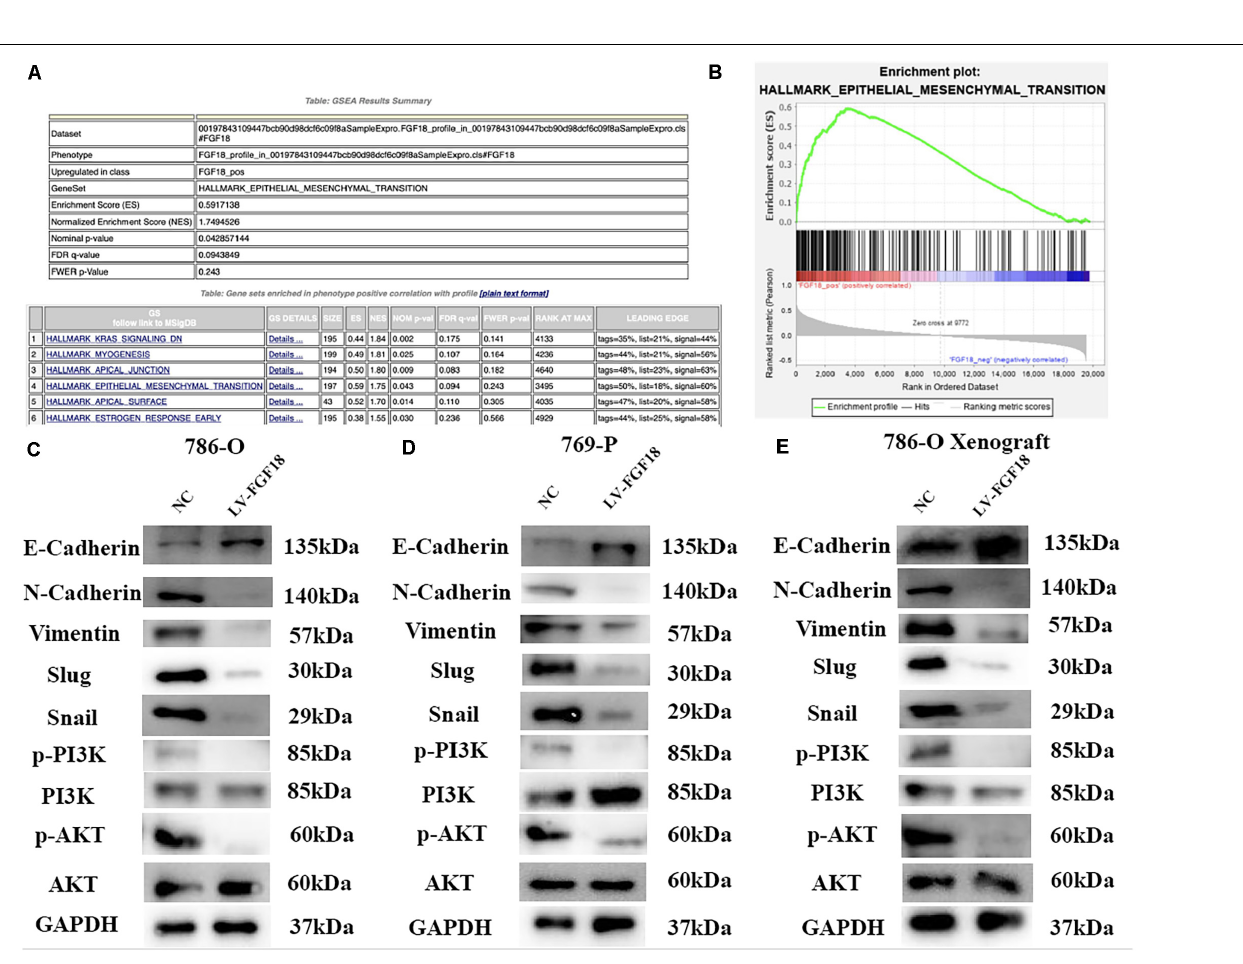
FIGURE 8 | FGF18 overexpression inhibits ccRCC progression via the EMT process through PI3K/Akt signaling pathway. (A) GSEA was performed to identify pathways between FGF18 high expression ccRCC tissues and low expression ccRCC tissues. (B) EMT was involved in the FGF18 high expression group. (C) Western blotting analysis of protein expression of EMT and PI3K/Akt signal pathway in NC and FGF18 overexpressed 786-O cell. (D) Western blotting analysis of protein expression of EMT and PI3K/Akt signal pathway in NC and FGF18 overexpressed 769-P cell. (E) Western blotting analysis of protein expression of EMT and PI3K/Akt signal pathway in NC and FGF18 overexpressed 786-O cell xenograft mice